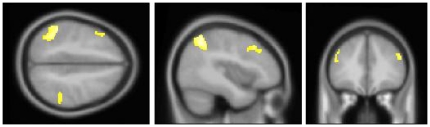
Cold-stimulation versus neutral baseline.Crosshair-position: x = −40 mm, y = 34 mm, z = 45 mm. Significant fronto-parietal activity was observed in response to cold-stimulation but unlike the TGI, no thalamic-activity emerged. See also Table 3.